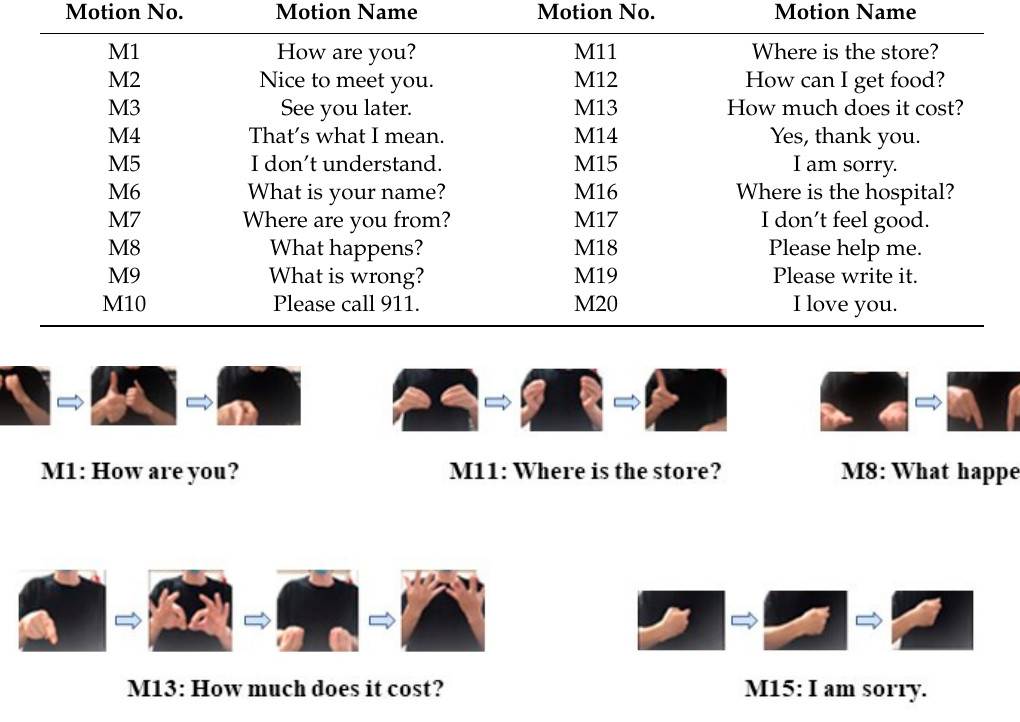
Figure 8. Sign language motions.